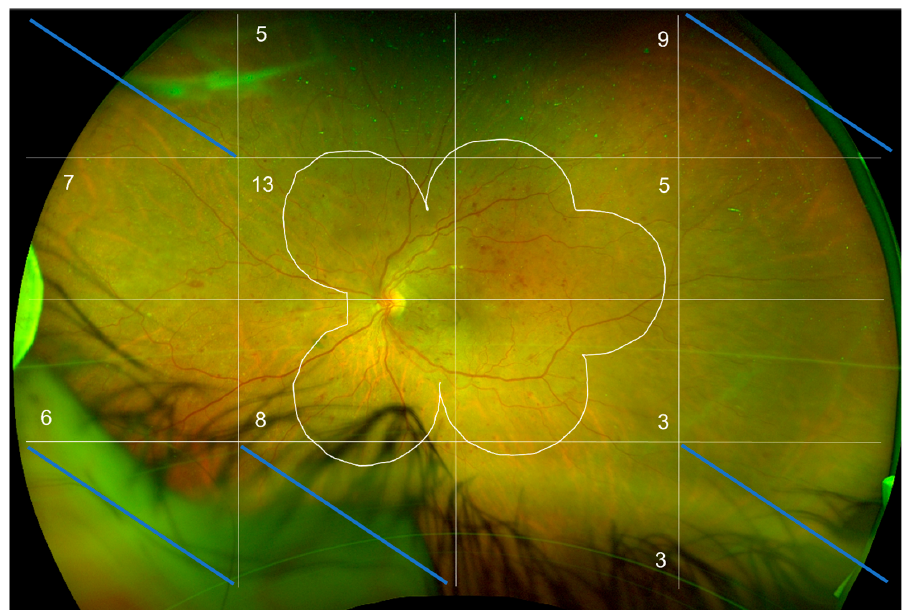
Figure 1. R/G UWF retinography of a left eye at baseline. The image was aligned with the image obtained at M12 and then divided into 16 blocks to facilitate the counting of peripheral lesions located outside the ETDRS 7-standard fields (white line). The numbers in the blocks stand for the number of peripheral lesions in each block outside of the ETDRS7-standard fields. Only the blocks analyzable at baseline and M12 were analyzed. In this figure, five blocks out of 16 were excluded, i.e., 31%. The average analyzable block for the 20 patients in the study is 49%. The number of predominantly peripheral lesions is noted in each block.